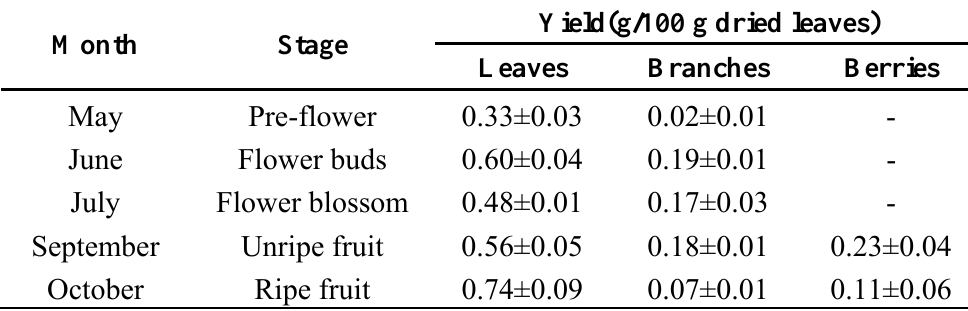
Table 1. Essential oil yields for the harvested months.